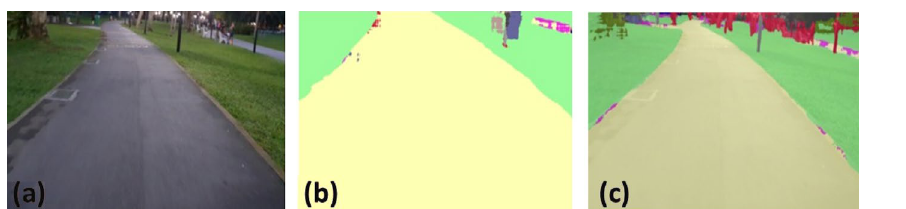
Figure 34. DeepLabv3+ segmentation results: pavement with night